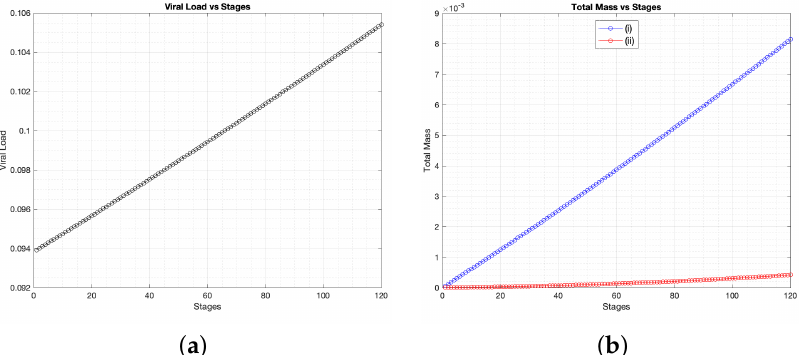
Figure 3. Comparison of viral load of SARS-CoV-2 and total mass of immune cells over time stages from 1 to 120 (which is equivalent to approximately 2.78 h to 14 days) for system (8) using the baseline values presented in Table 1. ( a ) viral load of SARS-CoV-2, ( b ) total mass of immune cells; (i) T cells and (ii) B cells.